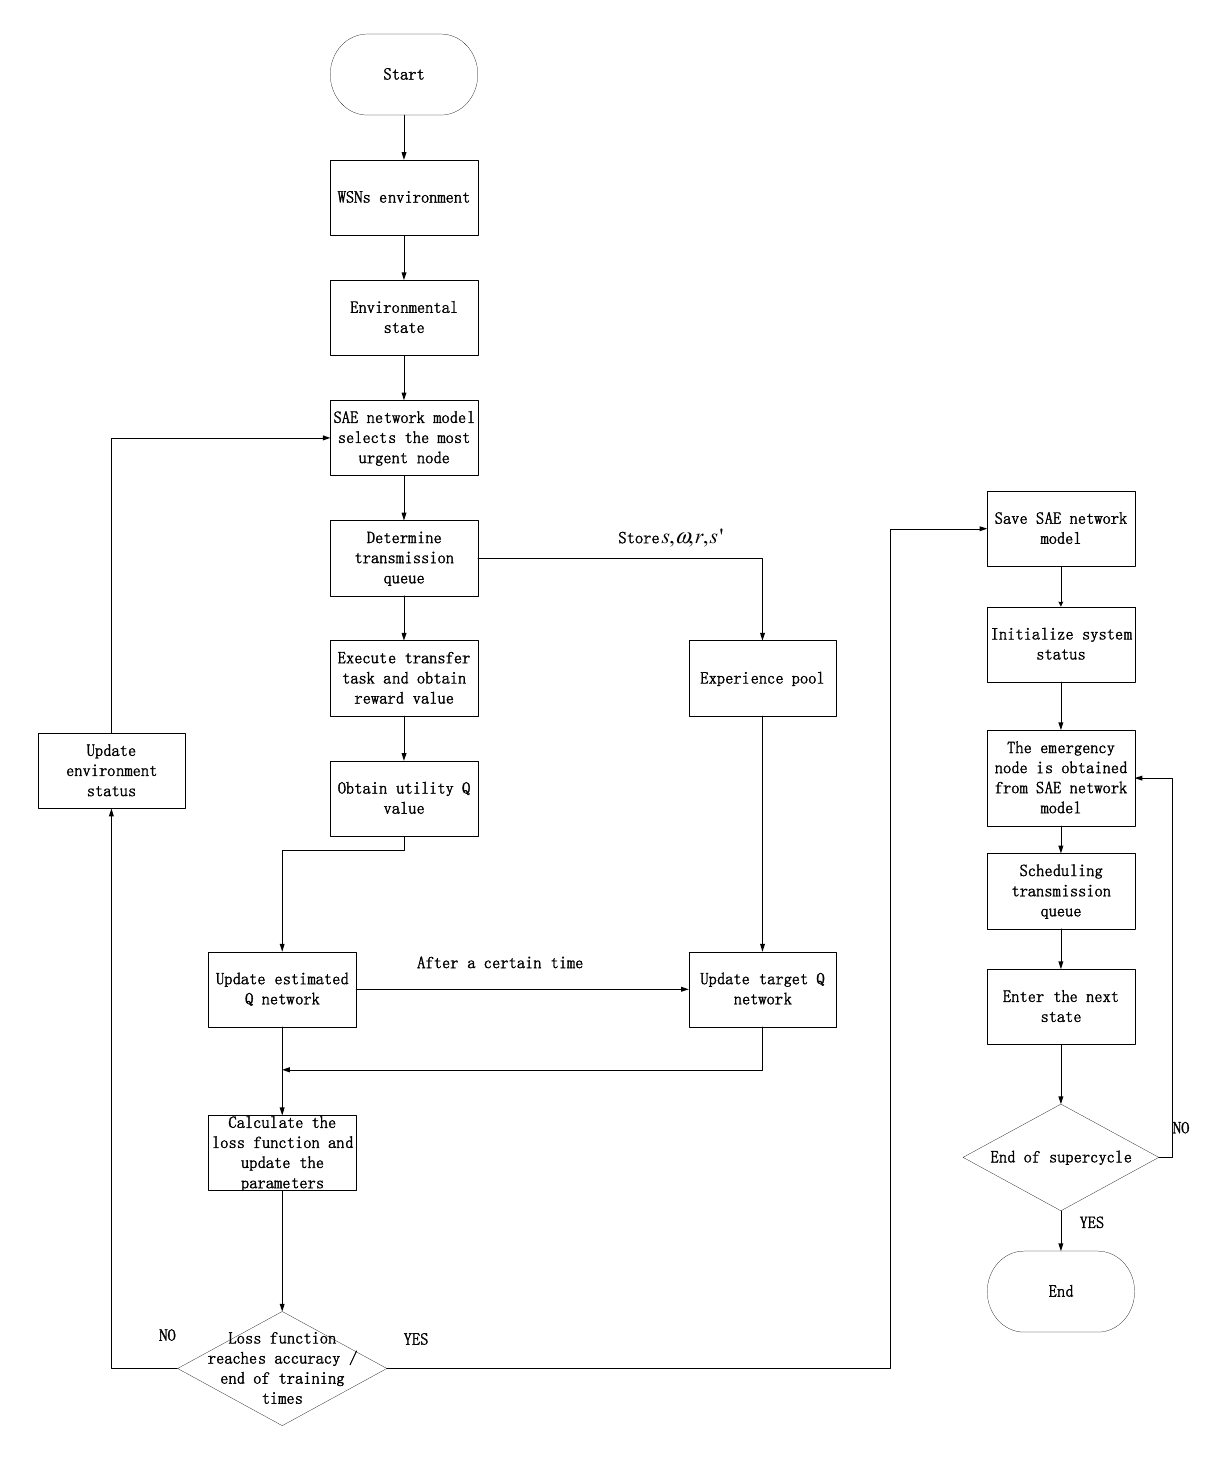
Figure 5. Flow chart of the RS-DQL algorithm.